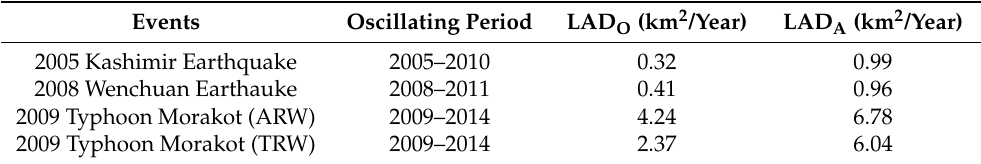
Table 6. Comparison of the average annual landslide area decline rate from the large earthquake events and the extreme rainfall